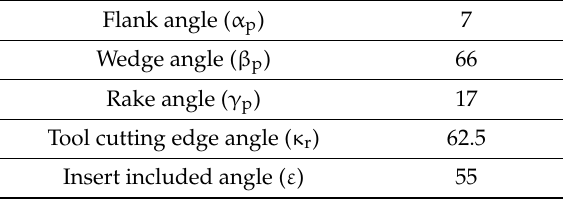
Figure 2. Tool geometry. Table 2. Cutting angles setup (°).